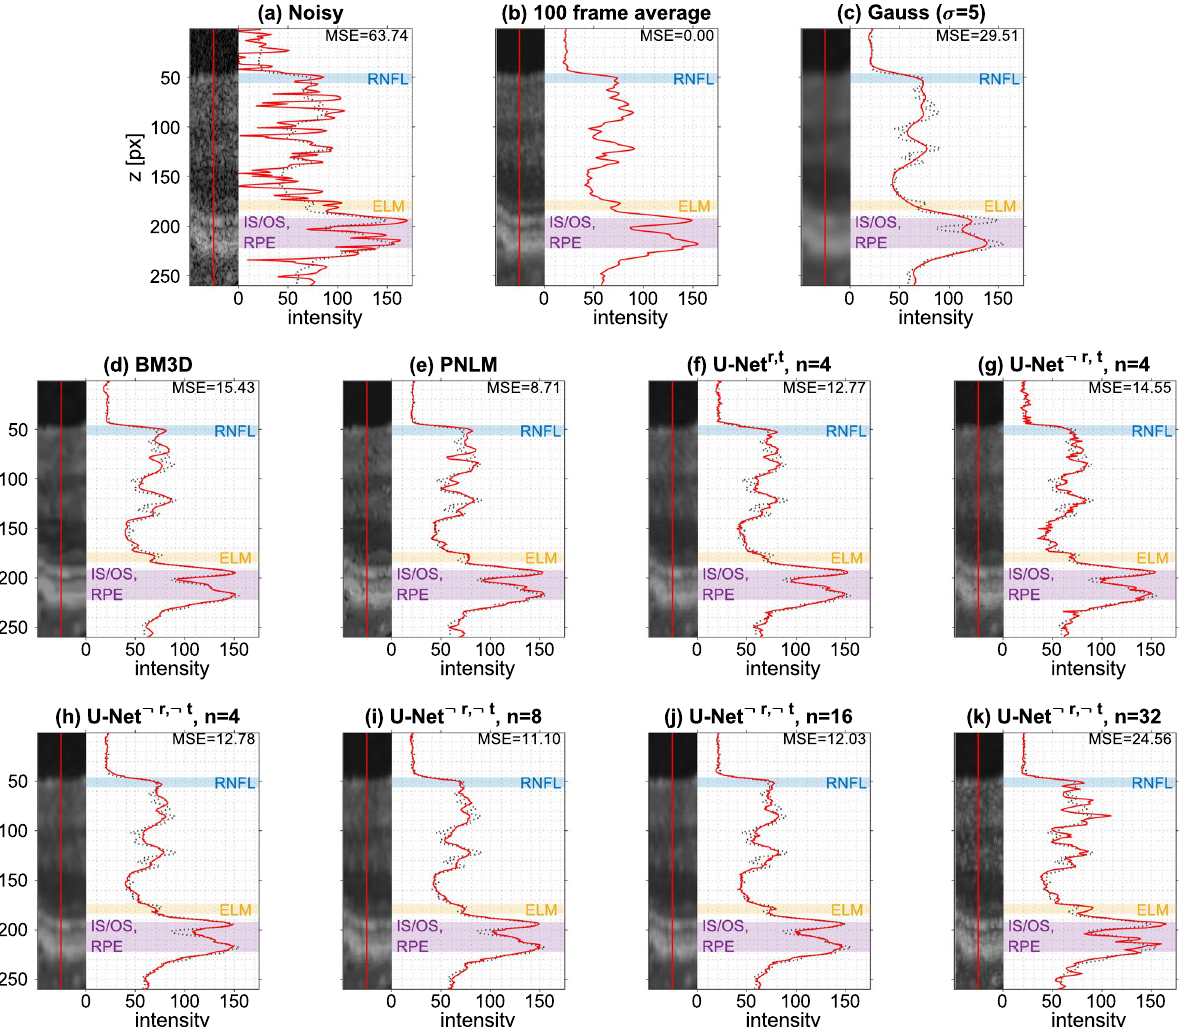
Figure 4. Intensity profiles along cropped A-scans at the center of the fovea for different denoising methods with multi-frame averaging as reference (dotted line) and highlighting of important retinal reconstruction and rendering settings, and manually synchronized with respect to robotic instrument move- ments. For every acquisition, the respective intensity-opacity transfer function, together with estimates for the gray value distributions of the volumetric data, is plotted on the left. Videos of these and more scenes with and without denoising and with different rendering transfer functions are provided as Supplementary Videos 2–4. In addition to the optimized renderings for each setting—with or without denoising—the videos also show record- ings with the transfer function optimized for the other setting. Even with an optimized transfer function, the rendering without denoising suffered from coarse surfaces caused by individual pixels falling beneath the noise floor, in particular due to speckle. With denoising, this effect was reduced due to a higher contrast between fore- and background and removal of speckle. This is especially visible for retinal imaging (Fig. 6a,b), where SNR was further reduced due to losses of light intensity caused by absorption and scattering in the vitreous. For the visualization of the retina, the visibility not only of surfaces, but also of the surgical instrument was greatly increased since more signal was preserved. The lower noise floor which can be used together with denoising indicates a higher potential dynamic range, corresponding to a higher range of rendered gray values as shown in the histograms in Fig. 6. In all cases, a large fraction of the signal was discarded as background during rendering. Generally, this could be expected, since large portions of the data represented background which is not of interest for visualization. However, due to noise and especially (dark) speckles, a fixed gray value threshold led to removal of additional pixels and, ultimately, caused grainy surfaces. Denoising consistently allowed for a lower noise threshold, lead- ing to more pixels being visible, which indicates a better signal preservation. Especially for the posterior seg- ment, denoising considerably increased the fraction of rendered voxels from approximately 14% to 22%. For the anterior segment, approximately 24% were rendered compared to 23% without denoising. Notably, the gray value histograms after denoising contain narrow peaks. Both for the anterior and posterior segment, the most